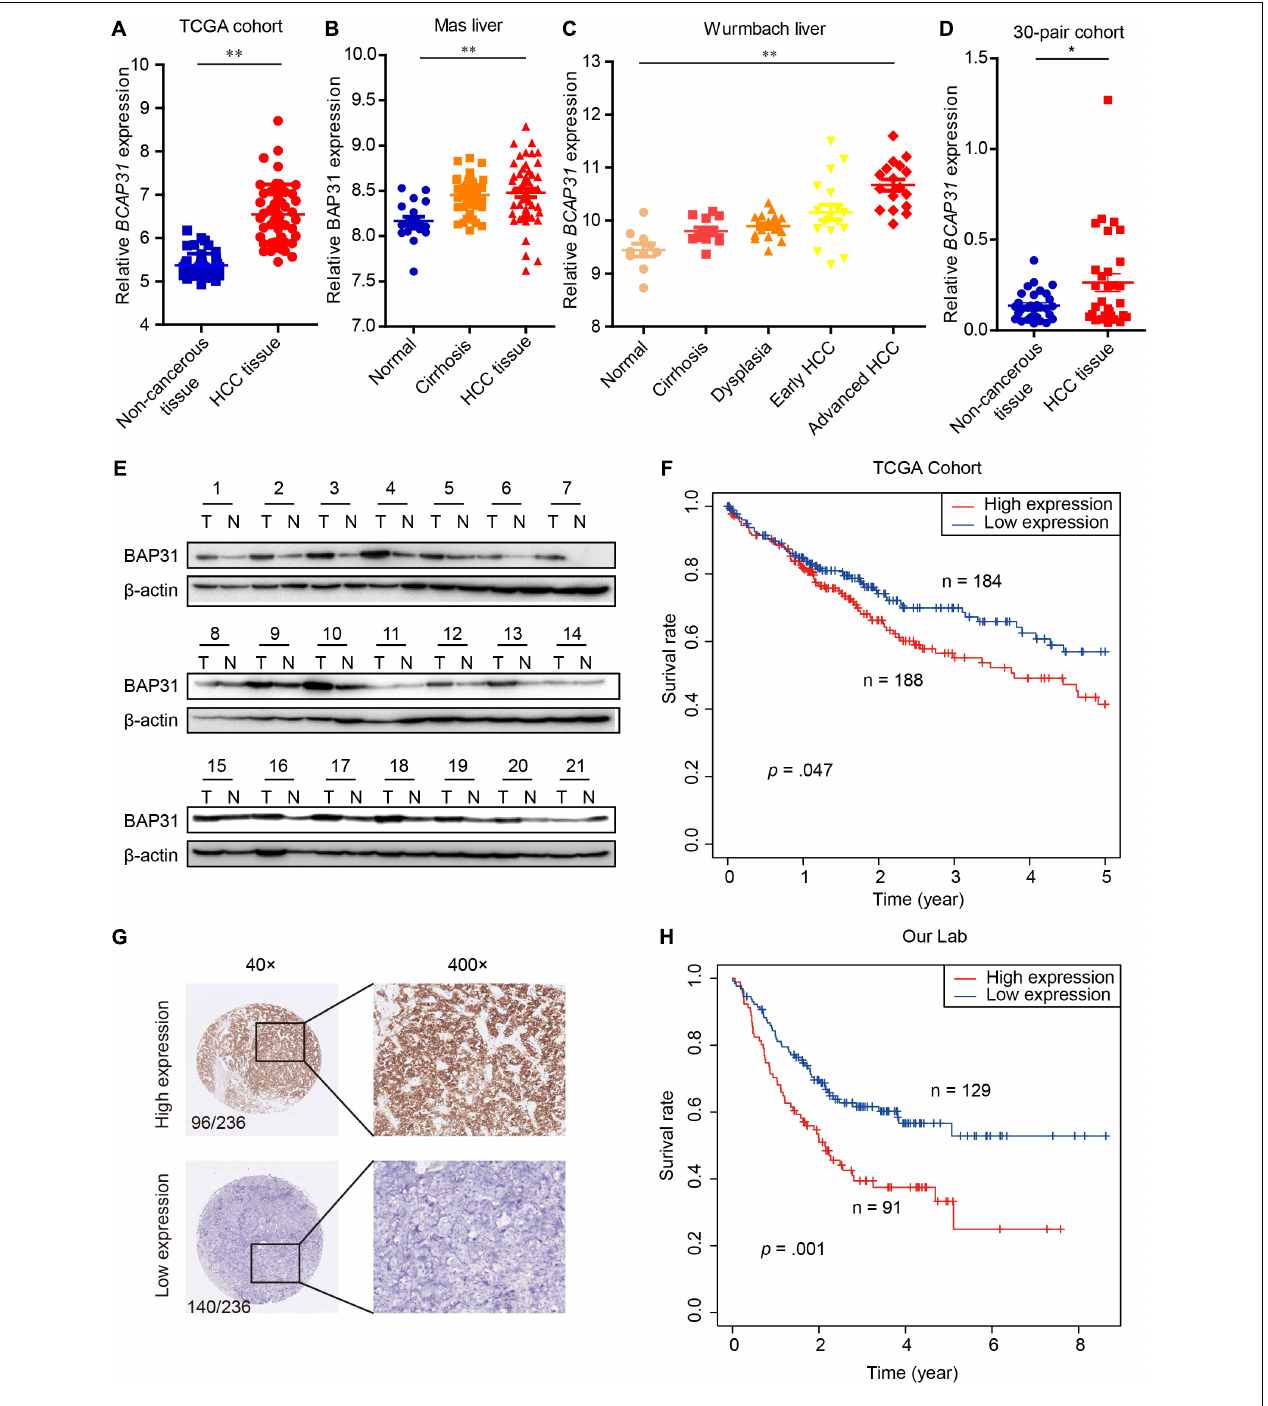
FIGURE 1 | Elevated BAP31 expression indicated a poor prognosis in human HCC. (A) Relative BAP31 mRNA ( BCAP31 ) expression in 50 paired HCC and adjacent non-cancerous tissues from TCGA. (B) Relative BAP31 mRNA expression in 19 normal liver tissues, 58 cirrhosis tissues and 38 HCC tissues from Mas liver cohort in GEO database. (C) Relative BAP31 mRNA expression in 10 normal liver tissues, 13 cirrhosis tissues, 17 dysplasia tissues, 18 early HCC tissues and 17 advanced HCC tissues from Wurmbach liver cohort in GEO database. (D) Relative BAP31 mRNA expression in 30 paired HCC and adjacent non-cancerous tissues from our lab. (E) BAP31 protein expression in 21 paired HCC and adjacent non-cancerous tissues from our lab, and β -actin was used as endogenous control. (F) Kaplan-Meier analysis of the relation of BAP31 mRNA expression with 5-year survival in TCGA cohort. (G) Representative images of IHC staining of BAP31 in human HCC tissues. (left) original magnification 40 × , (right) original magnification 400 × . (H) Kaplan-Meier analysis of the relation of BAP31 protein expression with overall survival in 236-patient cohort from our lab ( ∗ p < 0.05, ∗∗ p < 0.01).